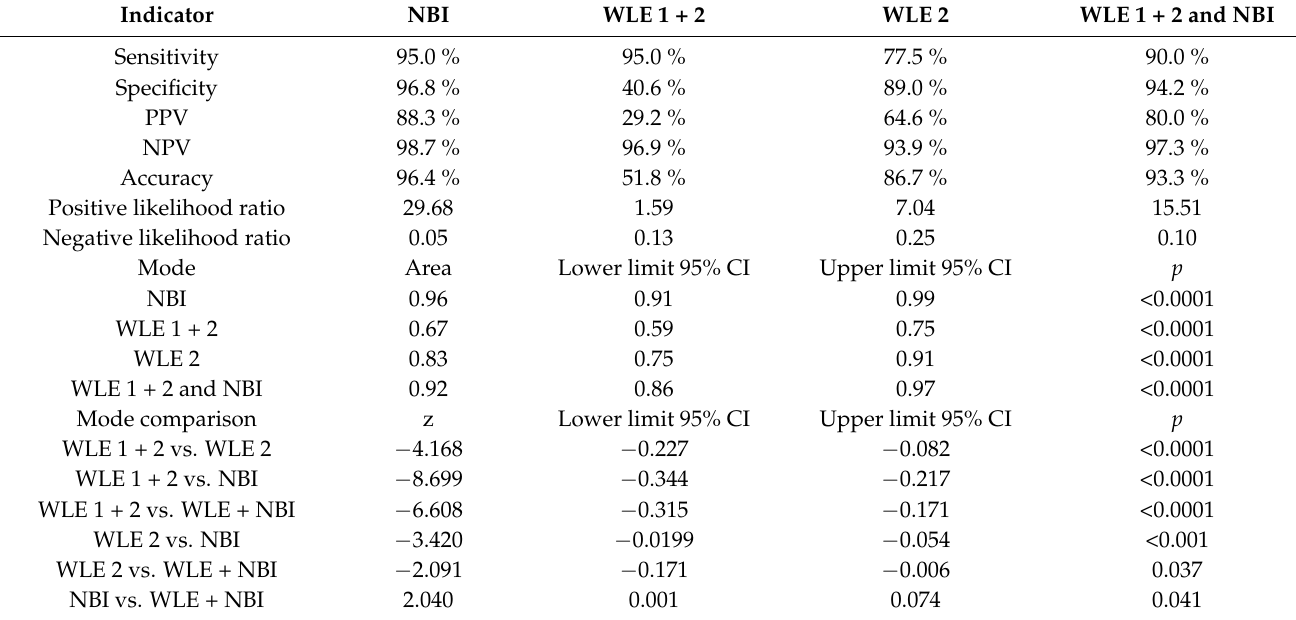
Table 2. Sensitivity, specificity, positive predictive value (PPV), positive negative value (PNV), accuracy, likelihood ratio and comparison of area under the ROC curves (AUC) of the four diagnostic modalities in group A.